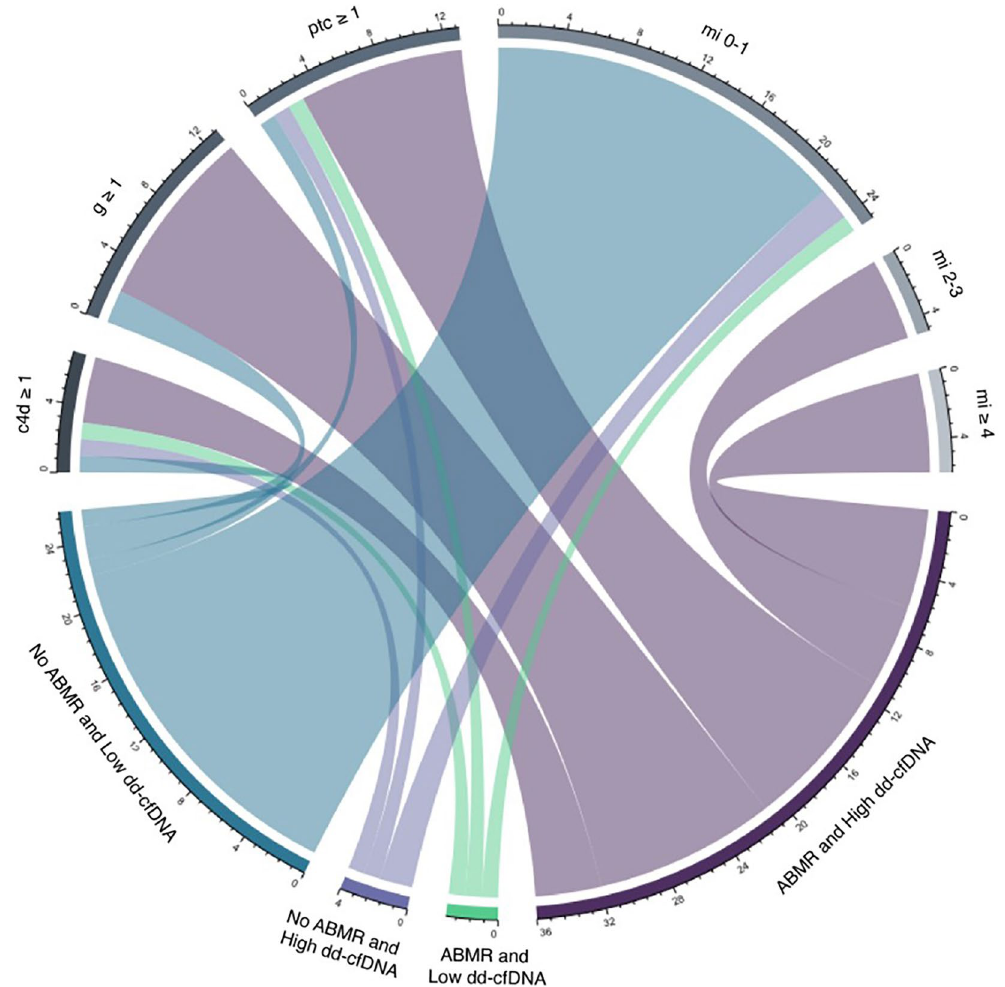
Figure 2. Distribution of histological lesions according to presence of ABMR and dd-cfDNA level. (The numbers in the upper part of the figure (elementary lesion sector) indicate the number of patients with each lesion. The numbers in the lower part indicate the total number of elementary lesions for each category of ABMR presence and dd-cfDNA